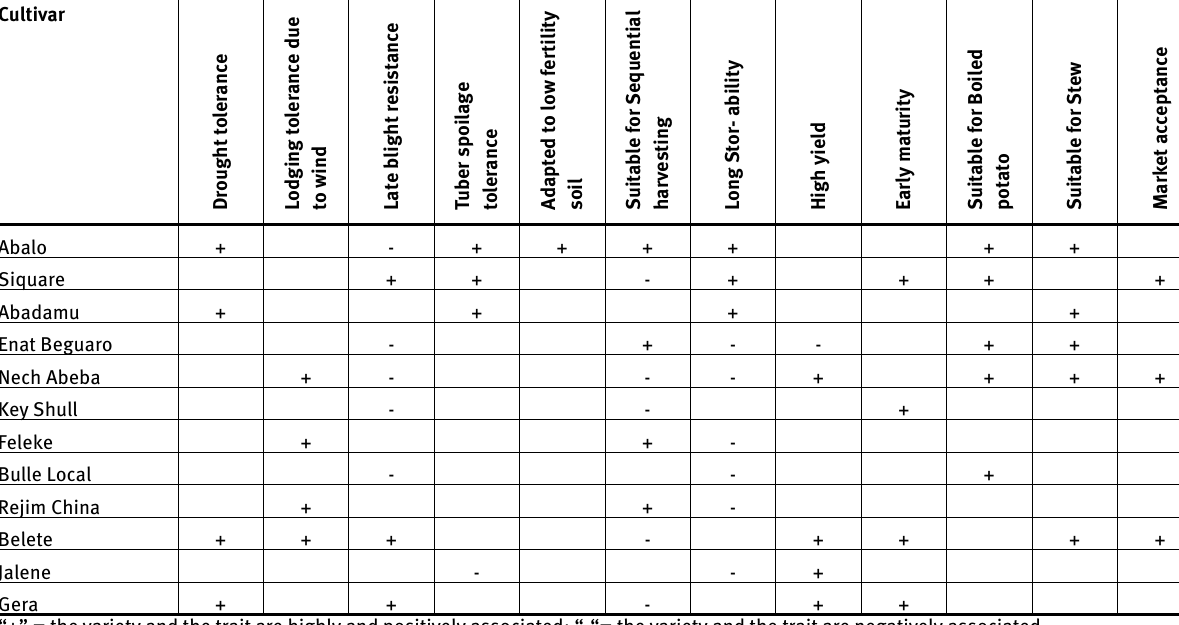
Table 3: Association of local and new cultivars with the 12 important variety traits studied under PVS a